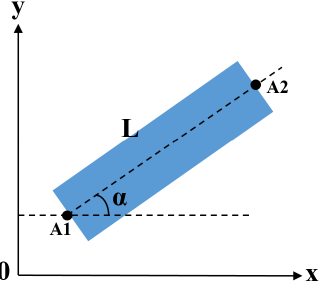
Figure 8. The angle α of a line segment. Figure 8. Neighborhoods of line segments.